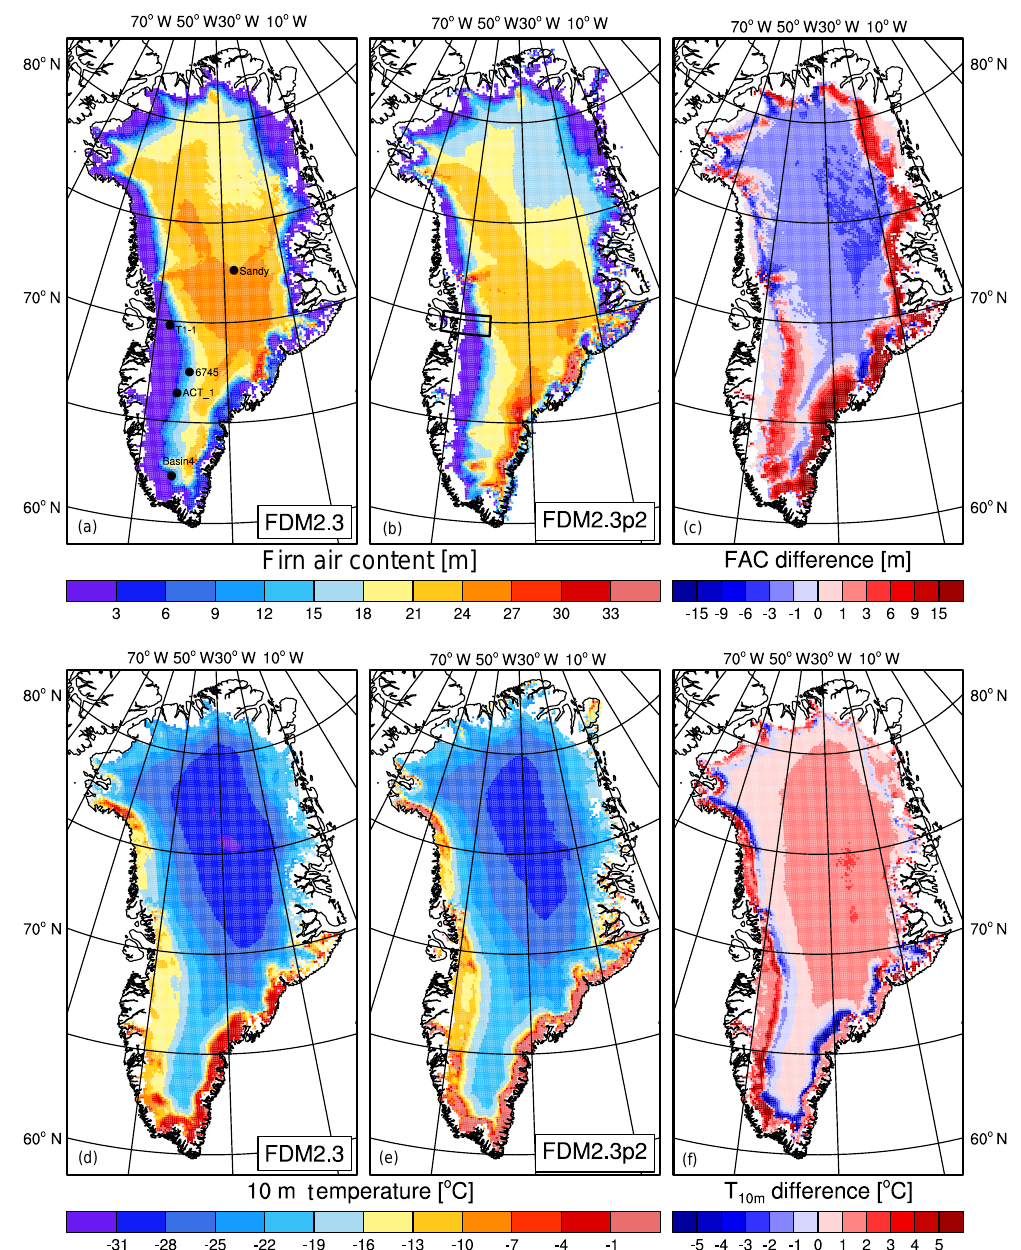
Figure 3. Firn air content (FAC) and 10m temperature ( T 10m ) as simulated by the IMAU-FDM: (a) FAC as simulated by FDM2.3; (b) FAC as simulated by FDM2.3p2; (c) the difference in FAC (FDM2.3p2 minus FDM2.3); panels (d–f) are similar to panels (a–c) only for T 10m instead of FAC. Locations in (a) indicate the cores used in Fig. 1b–f, while the box in (b) indicates the region used in Fig. 2.